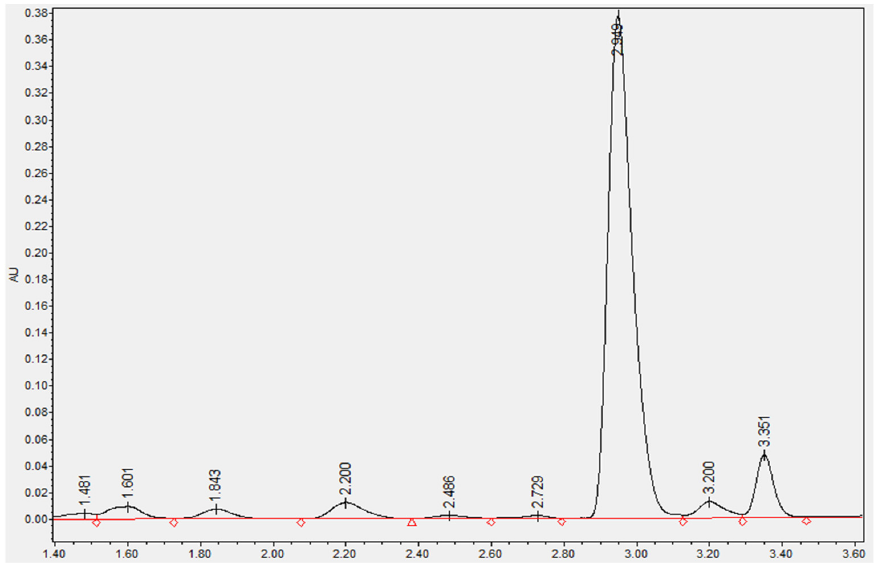
Figure 1. A typical UPLC spectra of the tested sample at 280 nm. Table 2. Phenolic acid composition of WWFs obtained by different milling methods.